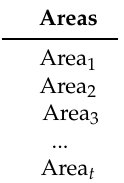
Table 2. Area list.